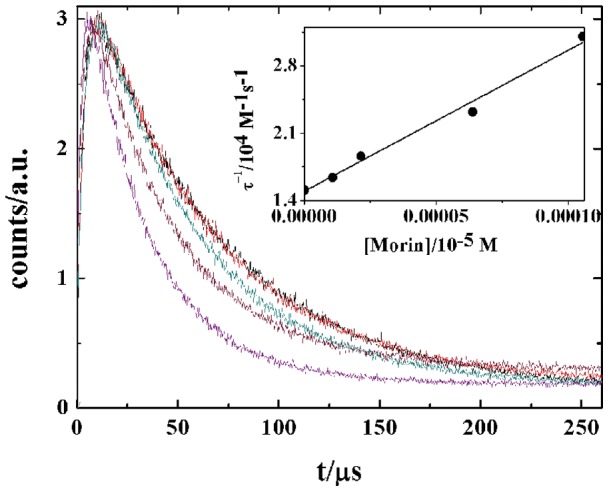
Singlet oxygen decays in the absence and the presence of morin.Rose Bengal as sensitizer, D2O as solvent. Inset: Stern-Volmer plot according to equation (1).